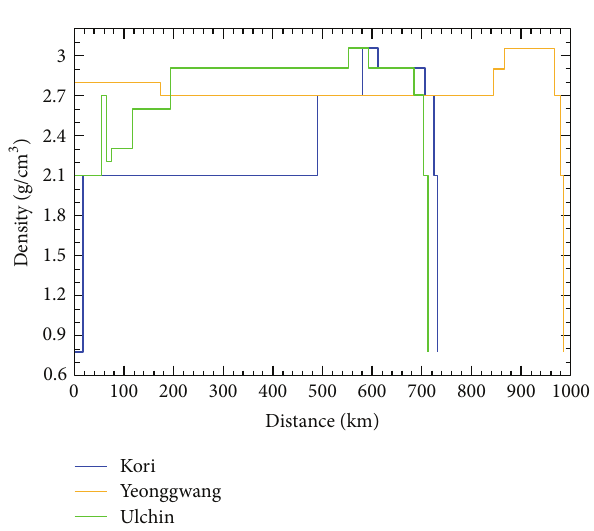
Figure 2: Real density maps used for specific sources, presented in intervals of constant density. Path between the Korean reactors and the